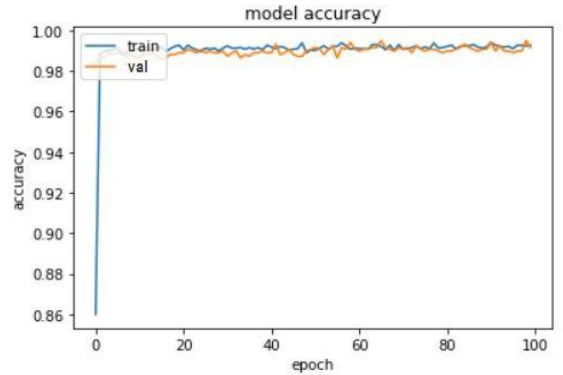
Figure 11. Validation (in orange) & Training Accuracy (in Figure 12: Validation (in orange) & Training Loss (in blue) during the training of AiCNNs for the classification blue) during the training of AiCNNs for classification of of MRI scans. MRI